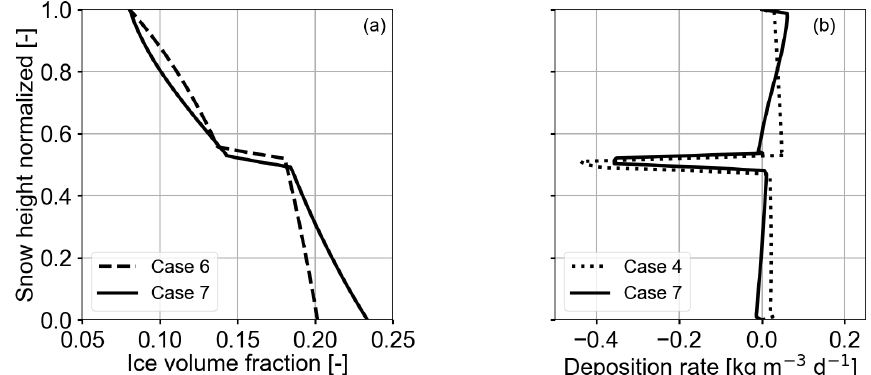
Figure 10. Panel (a) shows the ice volume fraction over the normalized snow height after a 3d simulation time obtained with a dynamic viscosity. Case 6 (Table 2) corresponds to mechanical settling solely, and Case 7 represents the fully coupled processes. Panel (b) shows the deposition rate over the normalized snow height for Case 7 and Case 4 after a 3d simulation time. Case 4 represents heat and vapor transport in the absence of settling. For the fully coupled processes (Case 7) the sublimation rate peak at the layer transition is slightly lower compared with inactive settling (Case 4). Both peaks are approximately at the same location of the normalized snow height. Case 7 shows reduced deposition rates in the area above the peak compared with Case 4. Case 7 also has a small peak in the deposition rate just above the sublimation rate